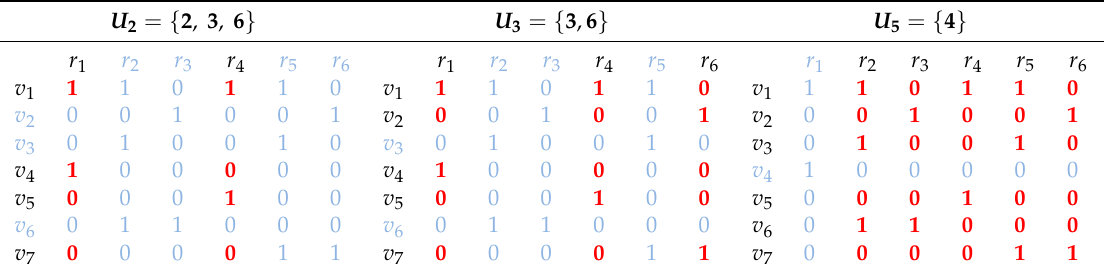
Table 4. Corresponding equation coefficients after excluding known variables from Equation